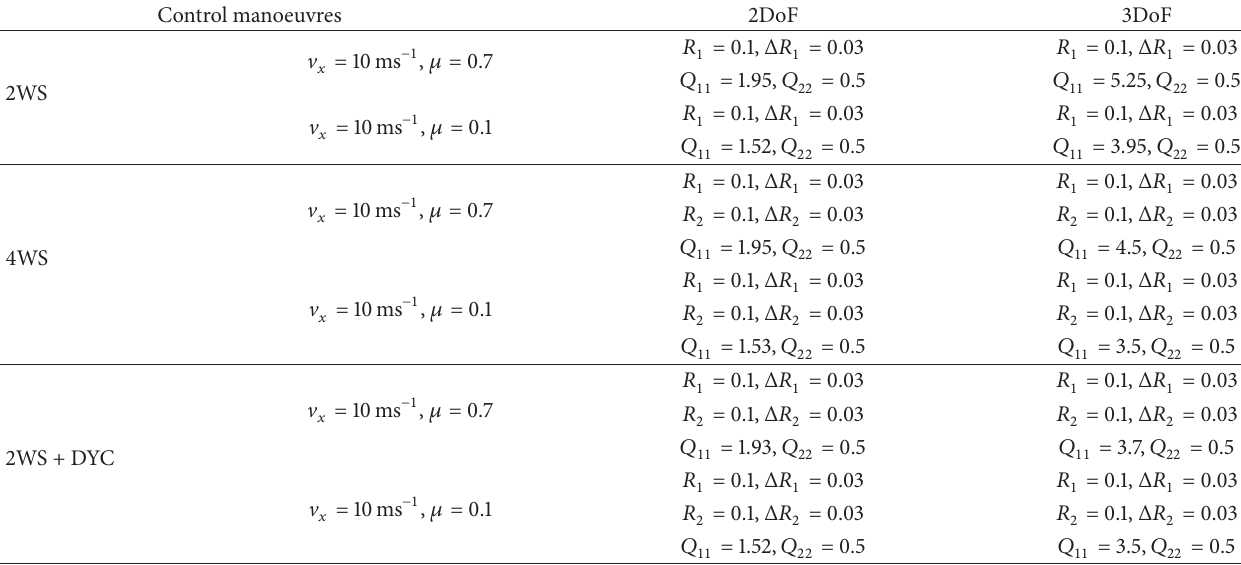
Table 3: Model predictive control weighting matrices parameters for V 𝑥 = 10ms −1